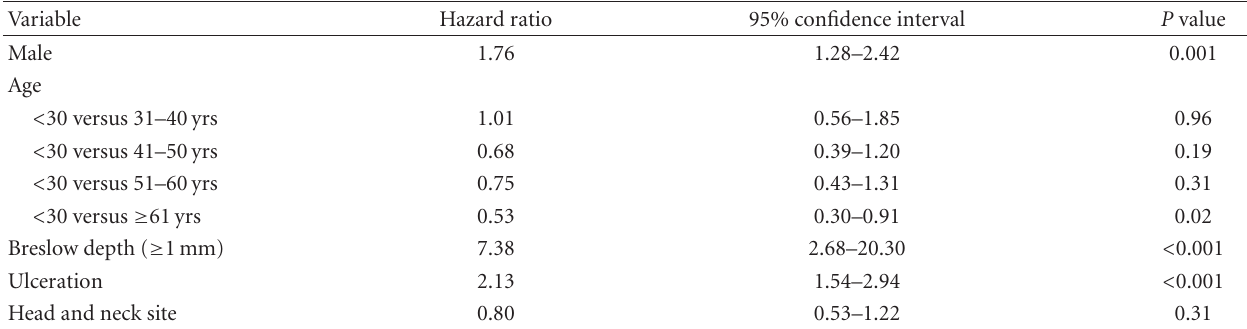
Table 5: Multivariate model for predicting SLN positivity with age based on quartiles demonstrates a trend that increasing age is associated with decreased SLN